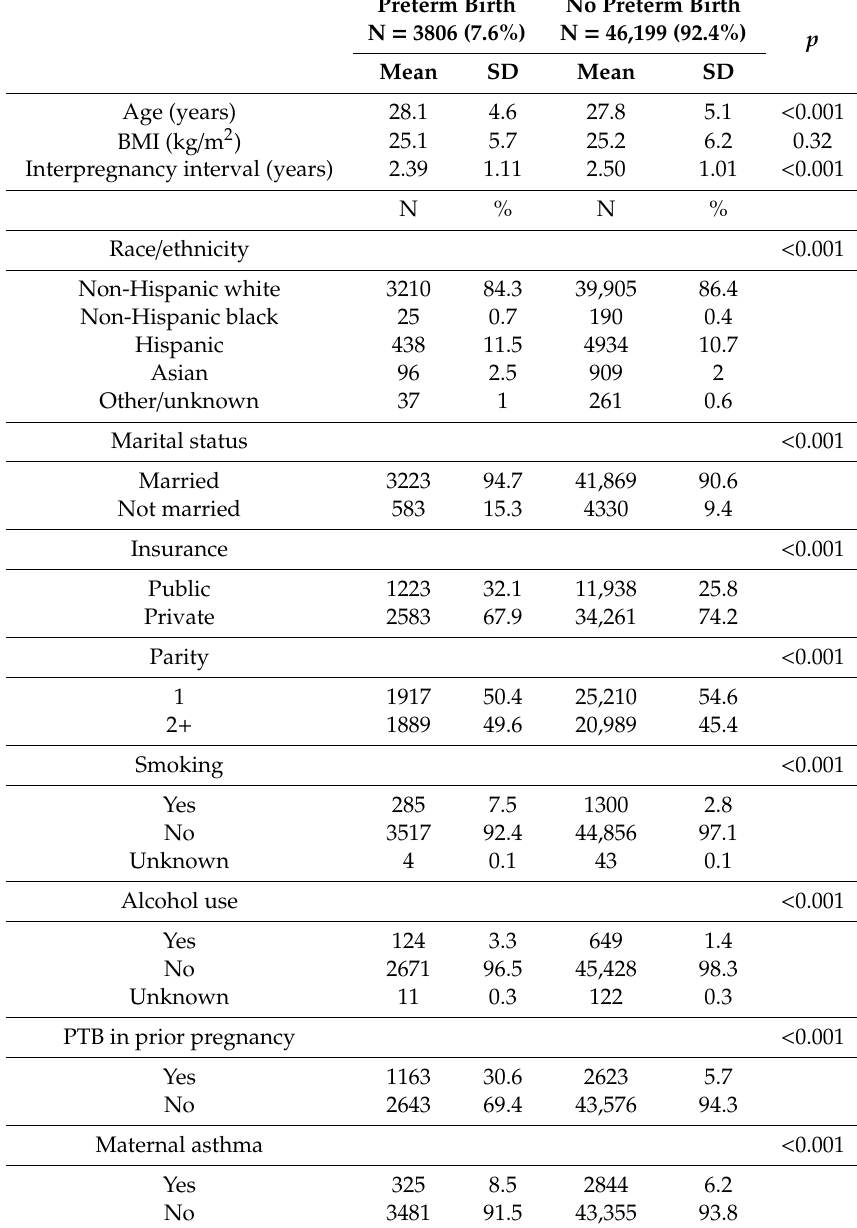
Table 1. Characteristics of the study sample by preterm birth status in the second pregnancy among 50,005 mothers, NICHD Consecutive Pregnancy Study,